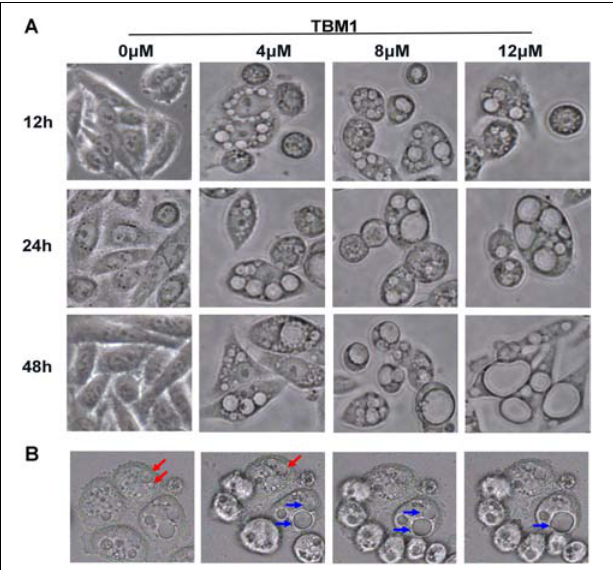
FIGURE 1 | TBM1 induces accumulation of cytoplasmic vacuoles in CRC cells. (A) SW480 cells were treated with different concentrations of TBM1 for indicated time. Extensive accumulation of cytoplasmic vacuoles in SW480 cells were visualized using phase-contrast microscopy. (B) Two newly formed vacuoles fused into a larger vacuole in SW480 cells upon treatment with 8 µ M TBM1. Arrowheads of the same color indicate fusion process.